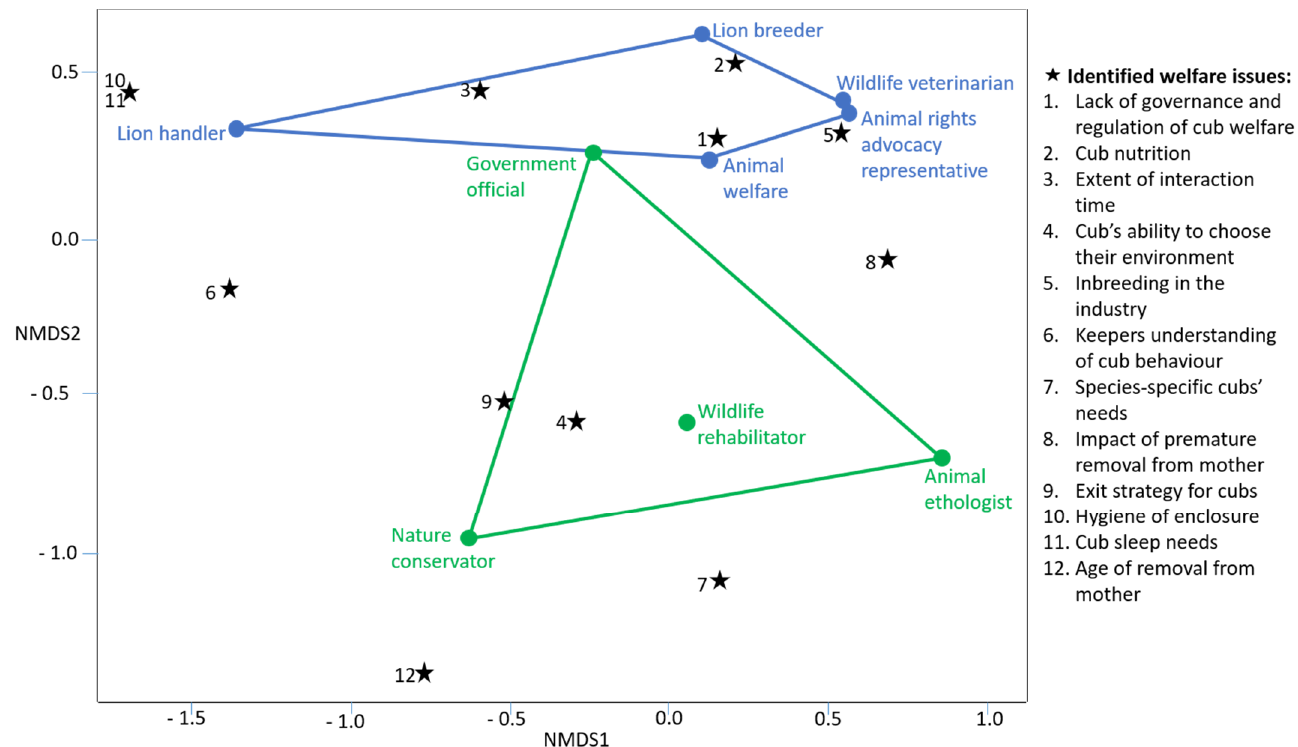
Figure 1. The non-metric multidimensional scaling ordination indicating the associations between the workshop stakeholder participants and the identified animal welfare themes.